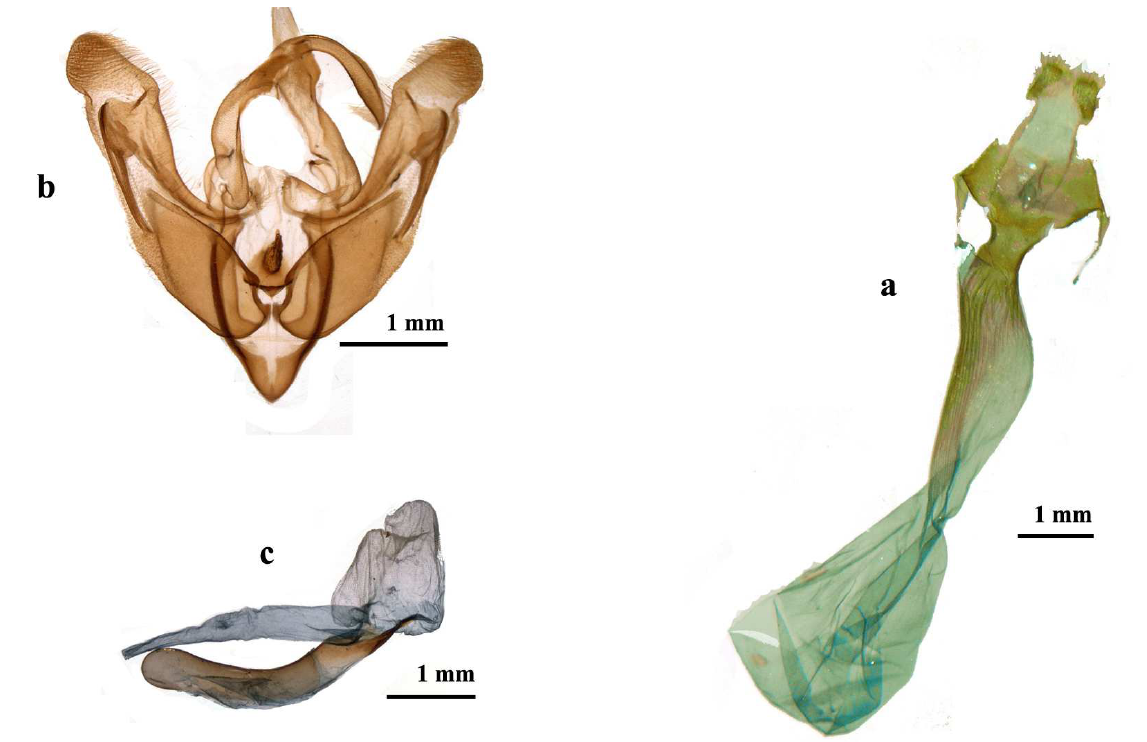
F IGURE 2. Genitalia of Hadula vassilinini , female genitalia (a) and male genitalia (b. armature, c. aedeagus with everted